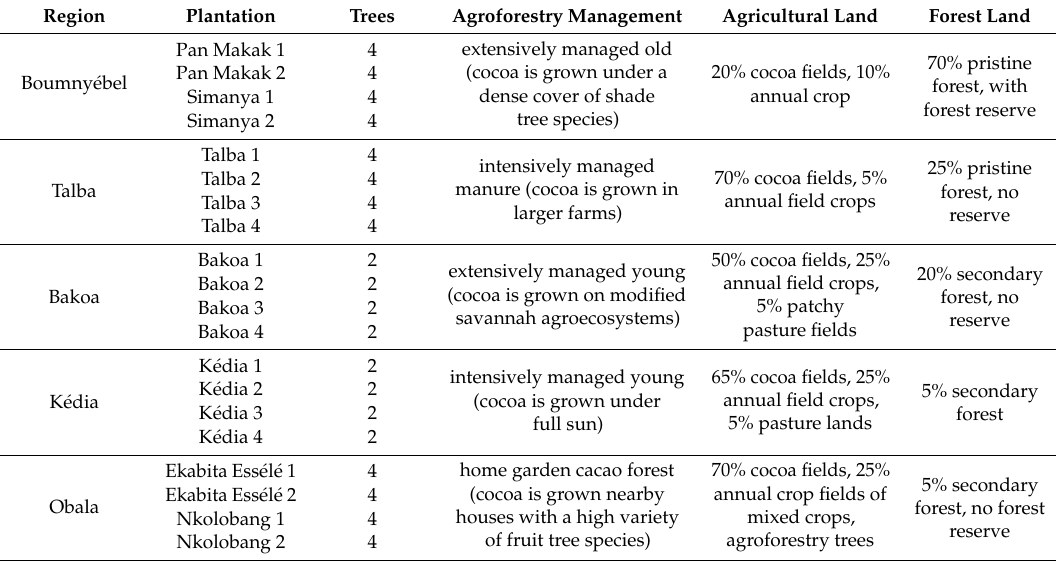
Table 1. Landscape characteristics of the five regions Boumny é bel (sites Pan Makak, Simanya), Talba, Bakoa, K é dia and Obala (sites Ekabita Ess é l é , Nkolobang). See Supplementary Table S1 for further